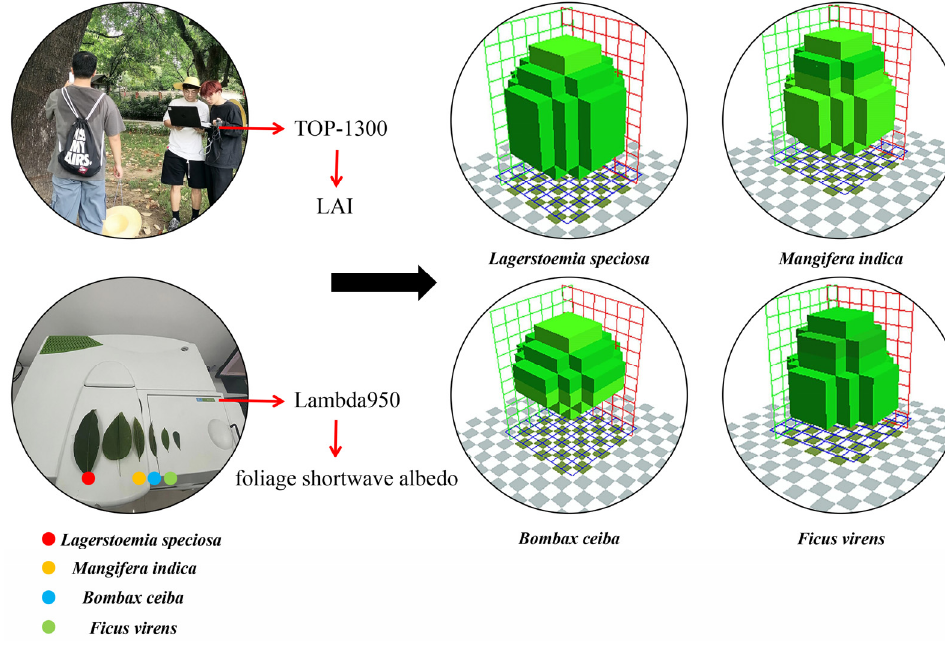
Figure 4. Measured physical parameters of the arbors (LAI and foliage shortwave albedo) and established ENVI-met arbor models. Table 3. Arbors and their parameters.